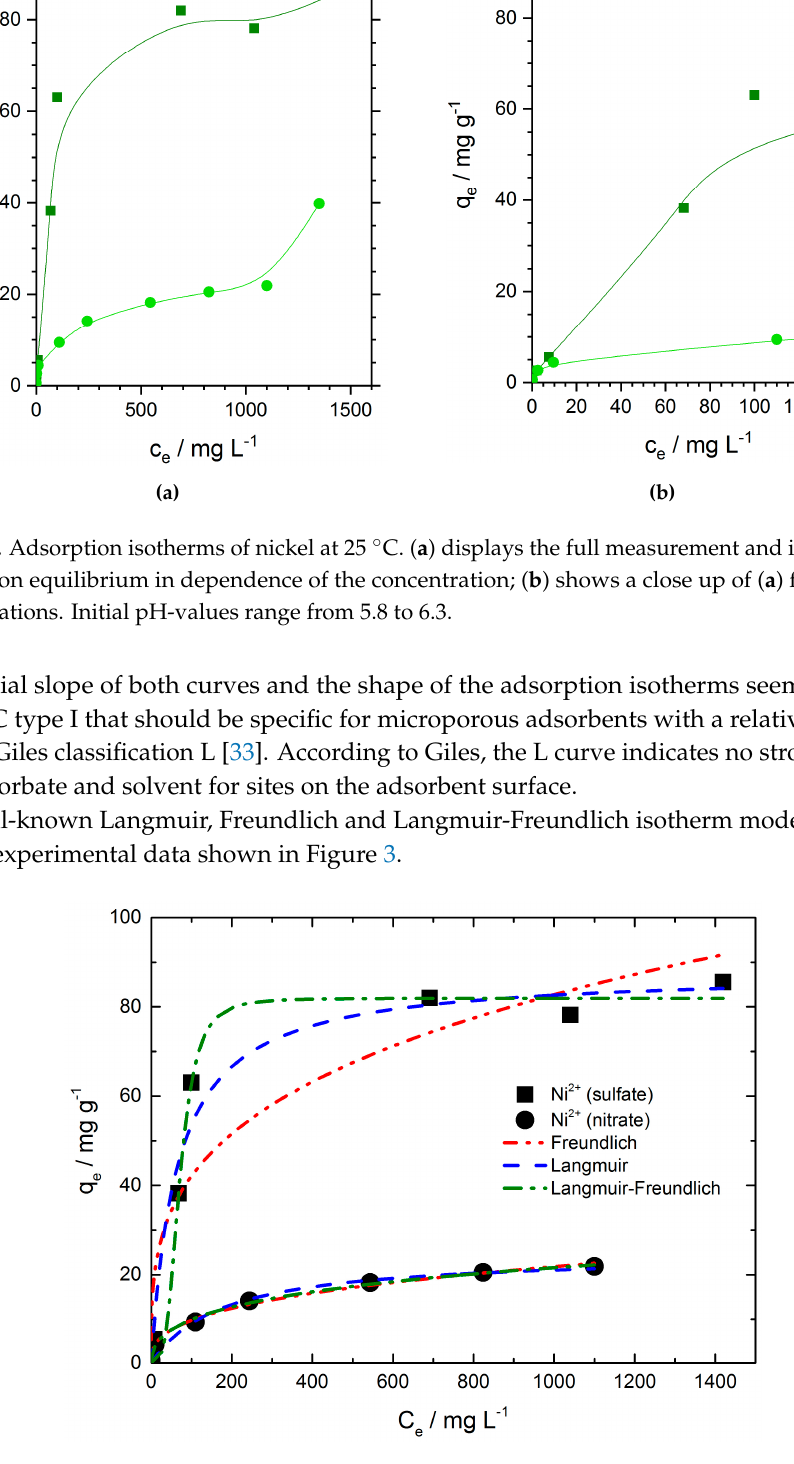
Figure 3. Adsorption isotherm models for nickel adsorption on chitosan flakes from nickel sulfate and nickel nitrate solution. The adsorption time and the initial pH-values were 24 h and 5.8 to 6.3, respectively.